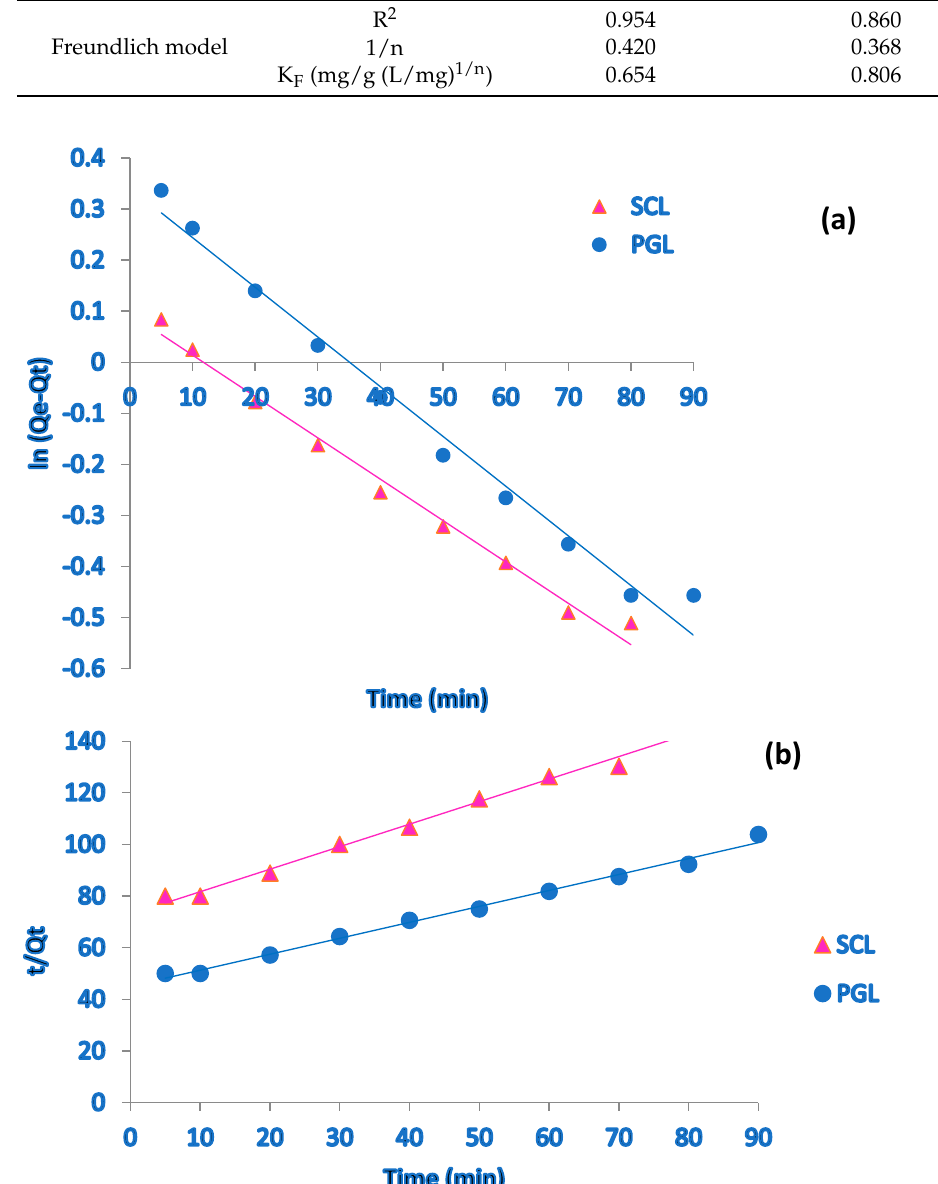
Figure 8. Kinetic adsorption curves ( a ) pseudo first order and ( b ) pseudo second order of F − onto SC and PG. Conditions: C 0 = 6 mg L − 1 , pH = 5, adsorbent dose = 8 g/L for SC and 6 g/L for PG.